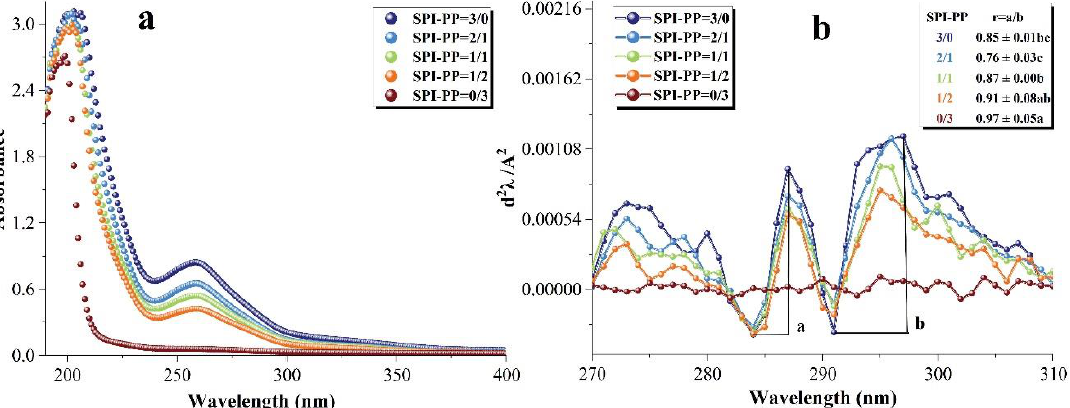
Figure 6. Changes in the UV–visible spectra of composite gels at 190–400 nm. ( a ) Second-order derivative UV–visible spectra and ( b ) corresponding values of r = a/b at (280–300 nm). Different lowercase letters in the figure indicate significant differences between samples in the same group ( p < 0.05).